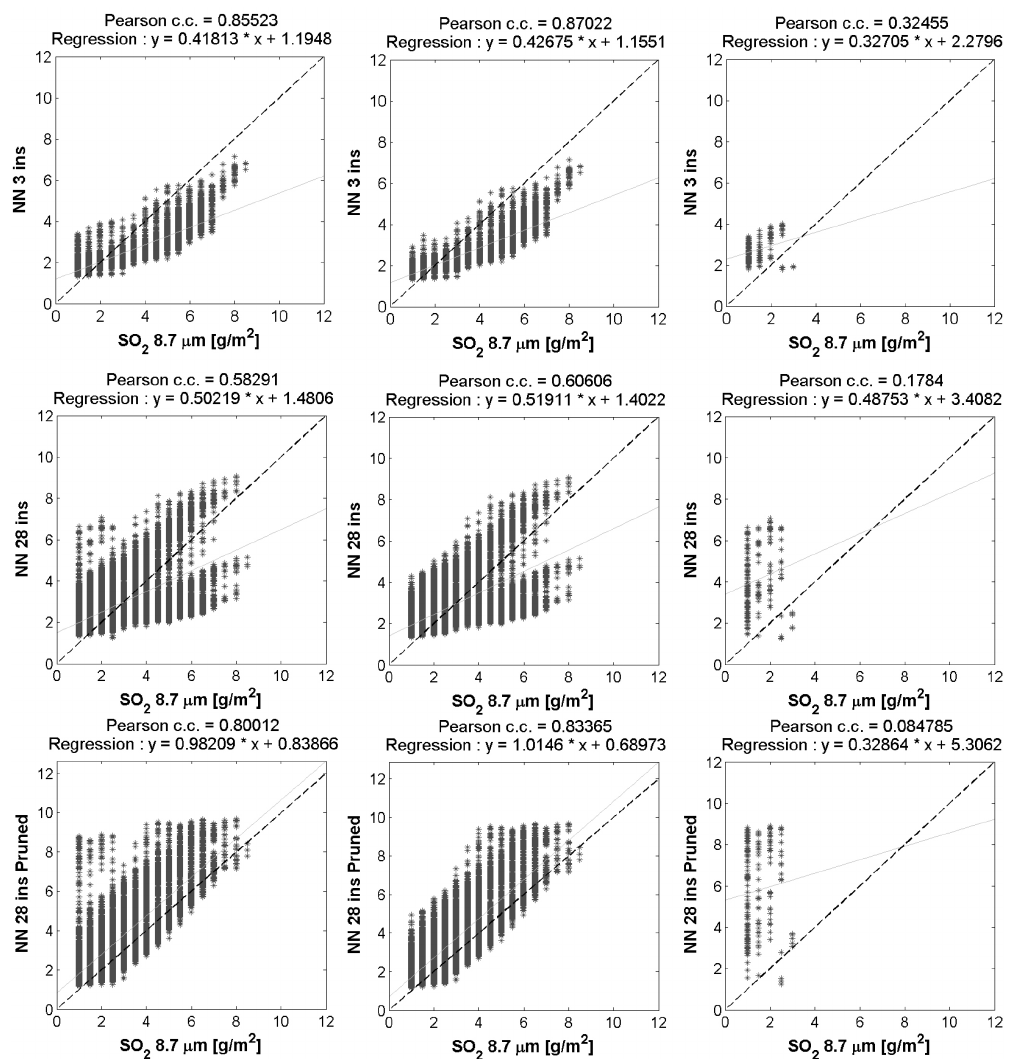
Figure 14. Scatterplots for SO 2 networks, 3 inputs (top row), 28 inputs (middle row) and 28 inputs pruned (bottom row), applied to the validation set of 11 May 2010, 14:05UTC, divided into total patterns (left column), patterns over sea (middle column) and patterns over meteorological clouds (right